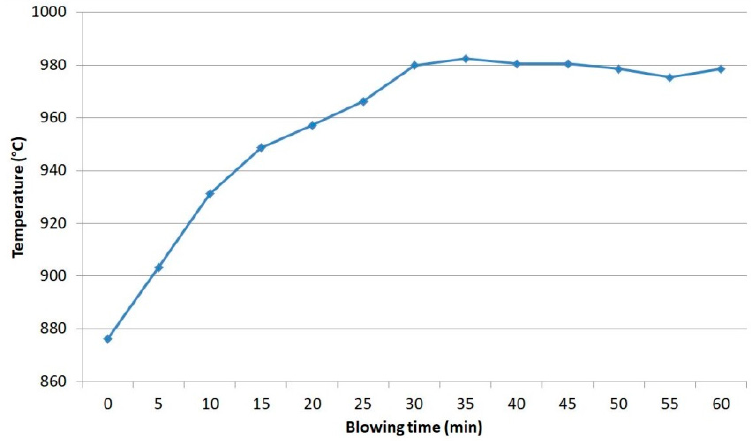
Figure 1. AlSi 7 Fe 1 casting alloy temperature mode as a function of oxygen blowing.